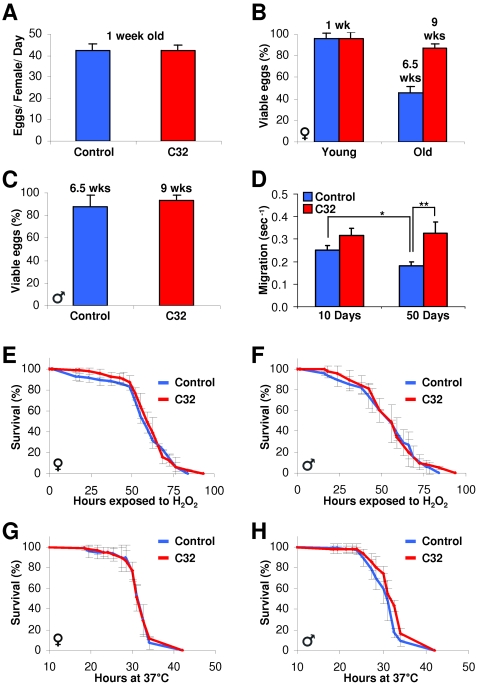
Old C32 Flies Are Active and Fertile.(A) Egg production was measured for 1-week old control and C32 females. (n = 15 per group) (B) Egg viability was assessed for control and C32 females at the indicated ages. (n = 15 per group) (C) Male 6.5 week old controls and 9-week old C32 flies were cultured with young control virgins and the percentage of viable eggs was evaluated. (n = 15 per group) (D) Activity, scored as crawling rate in a negative geotaxis assay, was analyzed in control and C32 flies at the indicated ages. (n = 30 per group) (E, F) 5 day-old adult C32 and control flies, cultured in identical conditions, were incubated with H2O2 and female (E) and male (F) survival was plotted. (n = 60 per group) (G, H) Female (G) and male (H) control and C32 flies were incubated at 37°C and survival was scored and plotted. (n = 60 per group) * p<0.02, ** p<0.03 by student's t-test. Error bars represent SEM.